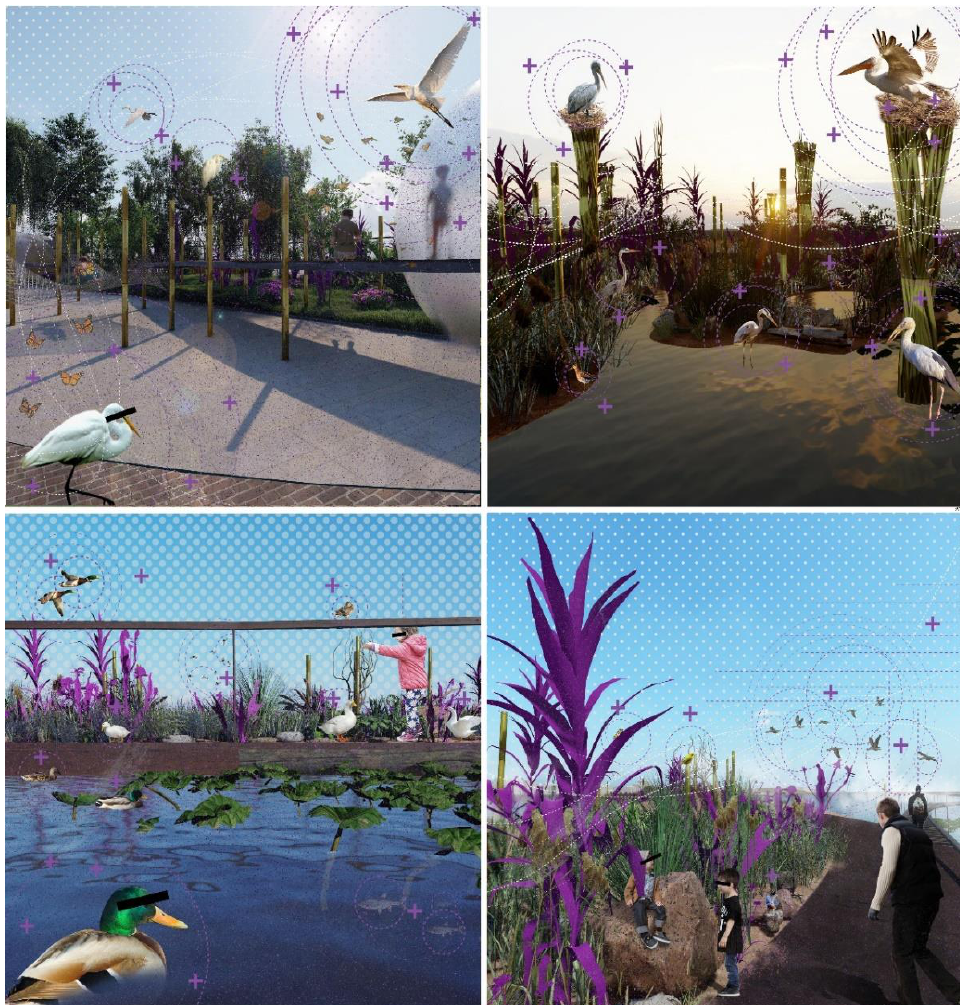
Figure 16. Eleni Kanellopoulou with Karolos Galanos (supervisor), 2022, Urban Safari 38.83, 20.70, Department of Architecture, University of Ioannina. Architecture beyond anthropocentric scope, as a hybrid between nature and humans. Reproduced with the permission of Kanellopoulou.